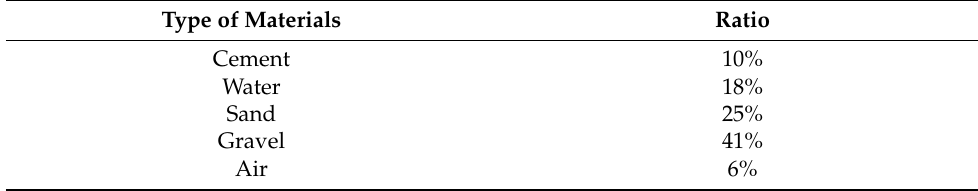
Table 2. Mix ratio of concrete use.